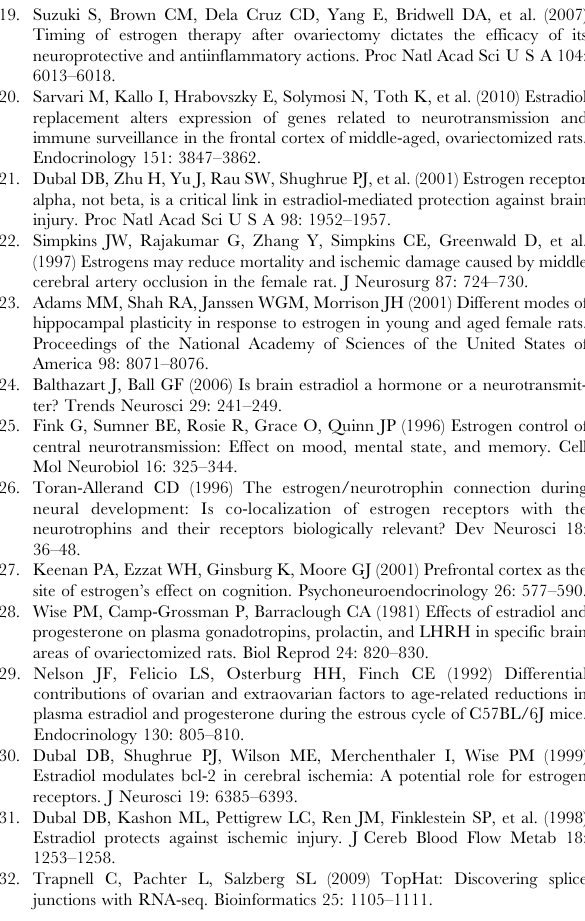
Figure S1 RNA gel demonstrating intact RNA samples. Native agarose gel electrophoresis was used to resolve the intact